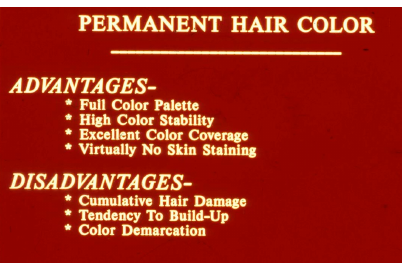
Figure 16. Rudimentary elements of permanent hair color.